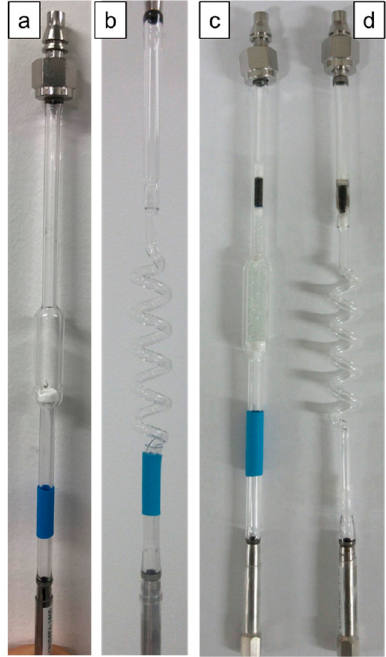
Figure 4. Two different types of quartz-glass cartridges for hydrogen generation from 2-PrOH. ( a